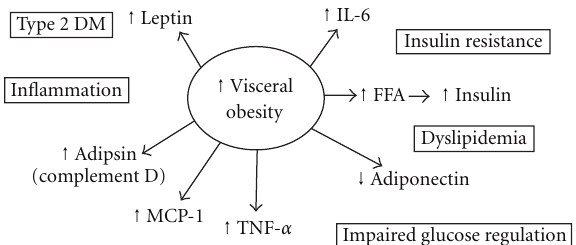
Figure 1: Potential causal agents in visceral obesity and the metabolic syndrome. The most dramatic form of obesity is char- acterized by excess visceral adipose tissue, which has been shown to be related to progression of symptoms of metabolic syndrome [11]. Among the symptoms of this syndrome is insulin resistance, which appears to be associated with increases in concentrations of inflammation markers in blood. Morphologically in lipid engorged adipocytes, the nucleus and the lipid synthetic apparatus of cells is marginalized and may negatively a ff ect further fat synthesis leading to hyperglycemia or hypercholesterolemia which is commonly observed in individuals with metabolic syndrome. Individual regulatory agents shown have been recently described [12]. DM: diabetes mellitus; FFA: free fatty acid; MCP-1: monocyte chemo attractant protein-1; TNF- α : tumor necrosis factor alpha; IL-6: interleukin